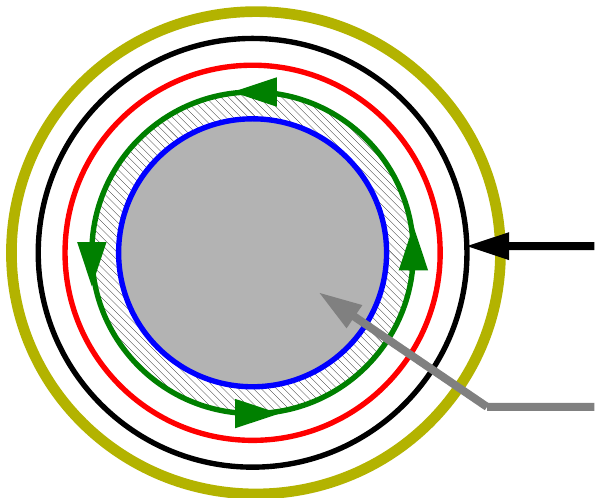
Figure 5: Location of the silicon pyrometer and the graphite pyrometer in the SINTEF CZ pro- cess (seen from above). Please refer to the main text for